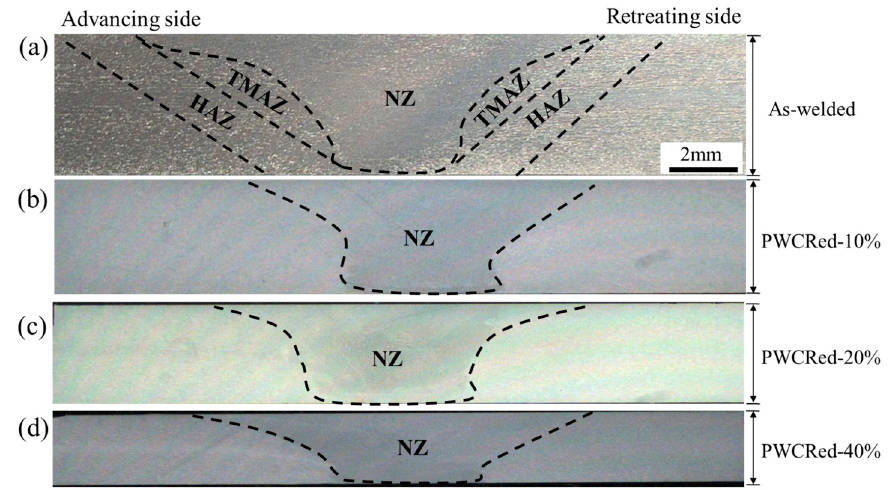
Figure 2. Cross-sectional view; ( a ) as-weld sample, ( b ) post-weld cold-rolling (PWCR)ed–10%, ( c ) PWCRed–20%, and ( d )